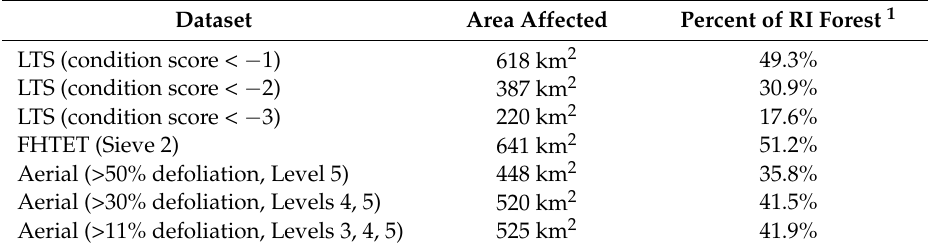
Table 2. Comparison of defoliation area estimates for Rhode Island, USA, June through September 2016 using Landsat Time Series (LTS) condition scores, remote sensing-based Forest Health Technology Enterprise (FHTET) product, and USFS aerial sketch maps.